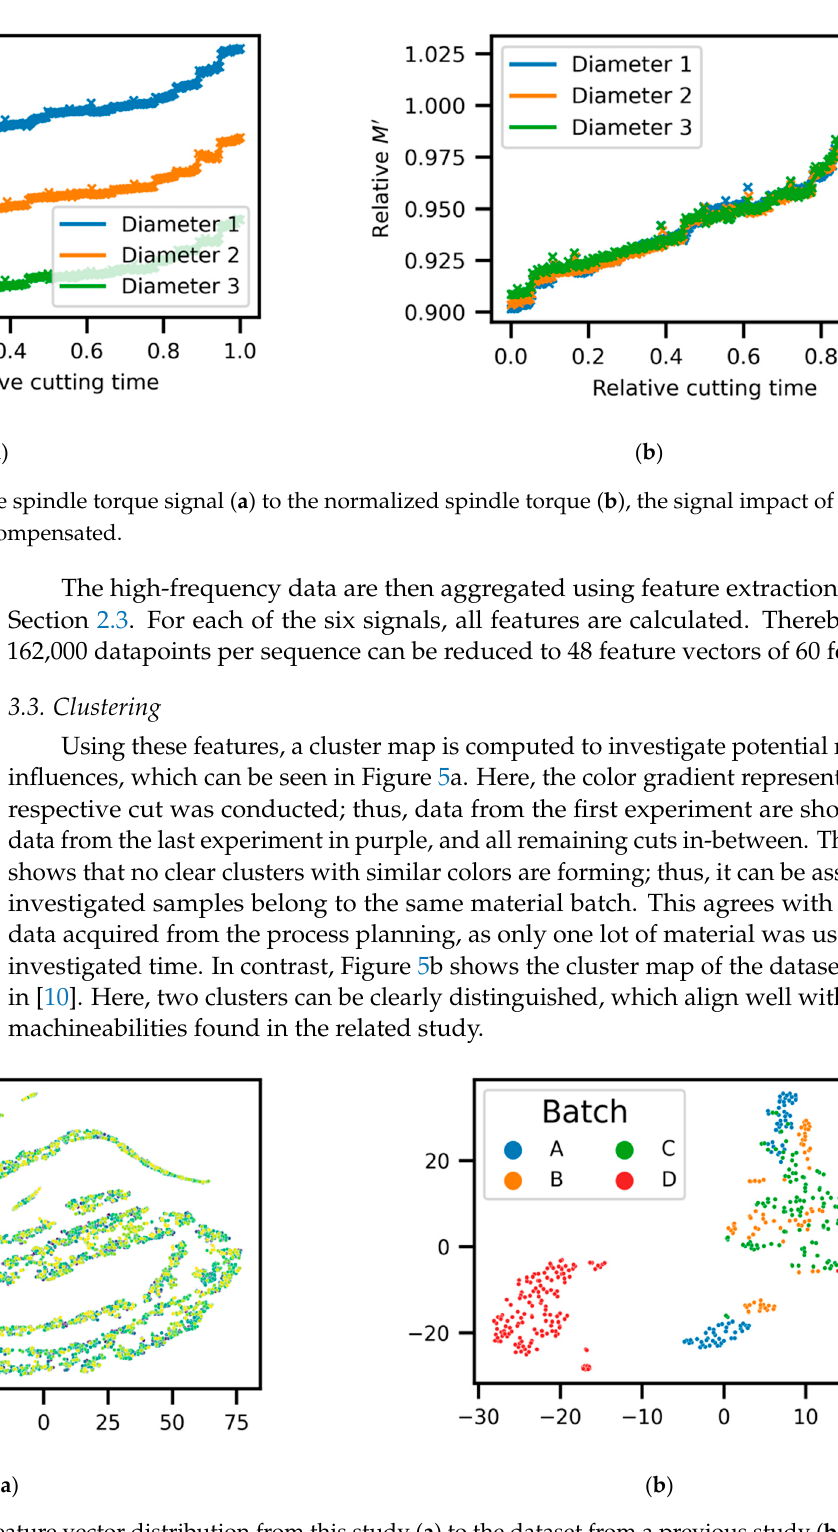
Figure 5. Comparing the feature vector distribution from this study ( a ) to the dataset from a previous study ( b ), no clear separable clusters can be observed, indicating that all samples belong to the same material batch.